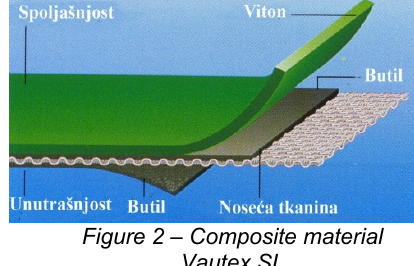
Figure 1 – Composite material Figure 2 – Composite material